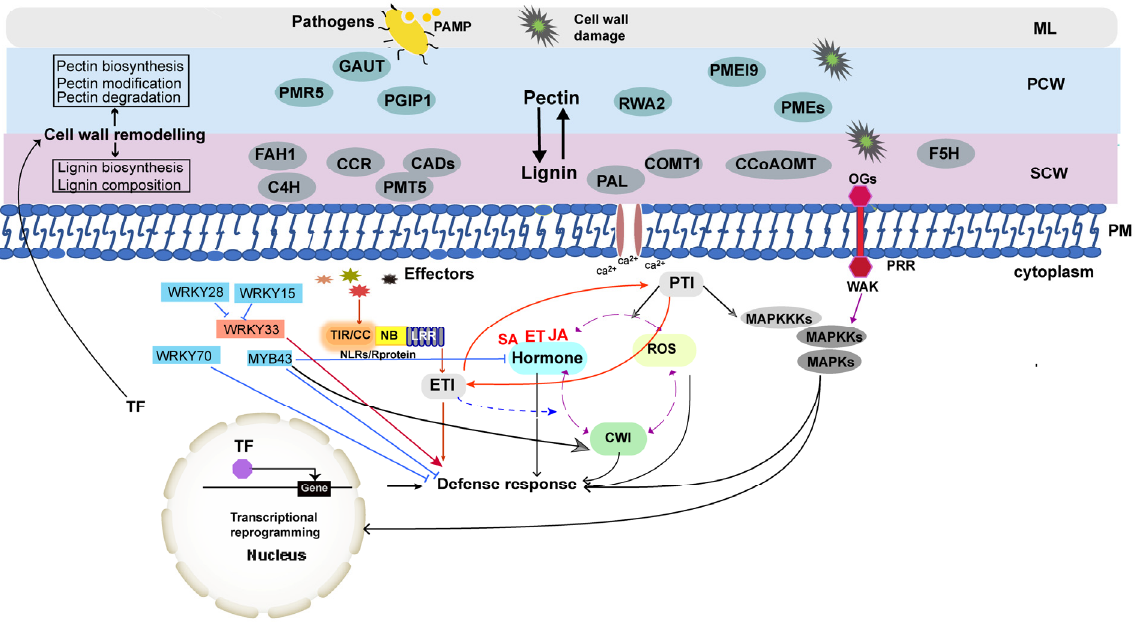
Figure 1. An overview of plant cell-wall-mediated immunity and its regulation in B. napus . The plant cell wall is made up of the middle lamella (ML), primary cell wall (PCW) and secondary cell wall (SCW). Middle lamella (ML) is abundant in demethylated homo- galacturonan (HG). Pectin has been proposed to be the major component determining the mechanical properties of PCW. Lignification occurs later in SCW production, through the polymerization of the lignin monomers (monolignols). The plant immune system involves PTI (pattern-triggered immunity) and ETI (effector-triggered immunity). Hallmarks of PTI include robust reactive oxygen species (ROS), hormone-signaling pathways, elevations in the cytoplasmic calcium ion concentration, the remodeling of the cell wall structure and the activation of mitogen-activated protein kinases (MAPK) signaling pathways. A range of genes related to pectin metabolism ( PMR5 , GAUT , PGIP , RWA , PME and PMEI ) and lignin biosynthesis and modification ( FAH1 , C4H , CCR , CAD , PMT5 , PAL , COMT1 , CCoAOMT and F5H ) have been identified to be associated with pathogen-induced immune responses in B. napus [7]. Alterations in the expression levels of these cell-wall-related genes affect the cell wall integrity, as well as cell-wall-derived DAMPs which act as de- fense signals to trigger PTI. Oligogalacturonides (OGs) are well-described